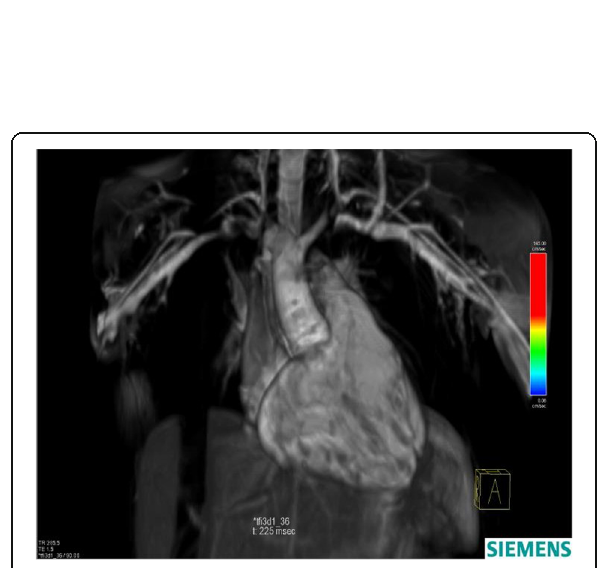
Fig. 2 3D data volume acquisition in a surgically repaired TOF patient with RVOT patch. TOF: tetralogy of Fallot, RVOT: right ventricle outflow